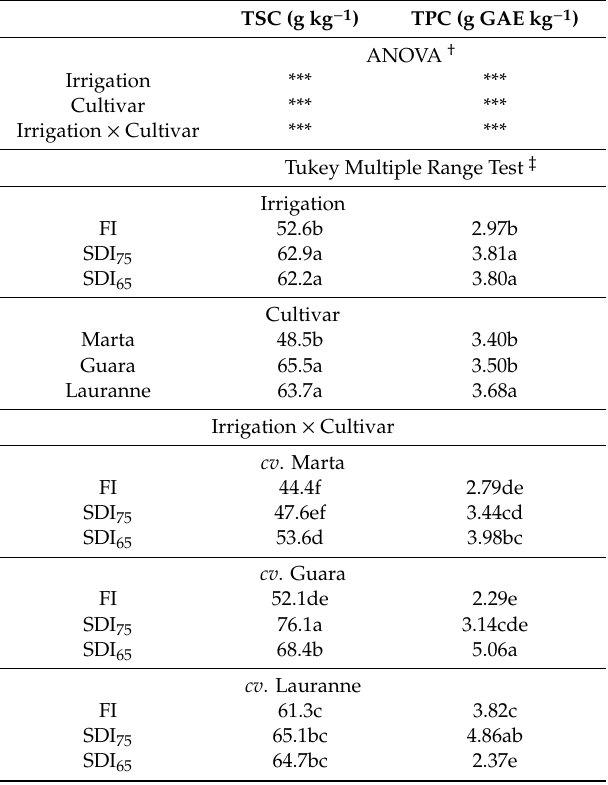
Table 4. Impact of deficit irrigation on total phenolic (TPC) and sugars contents